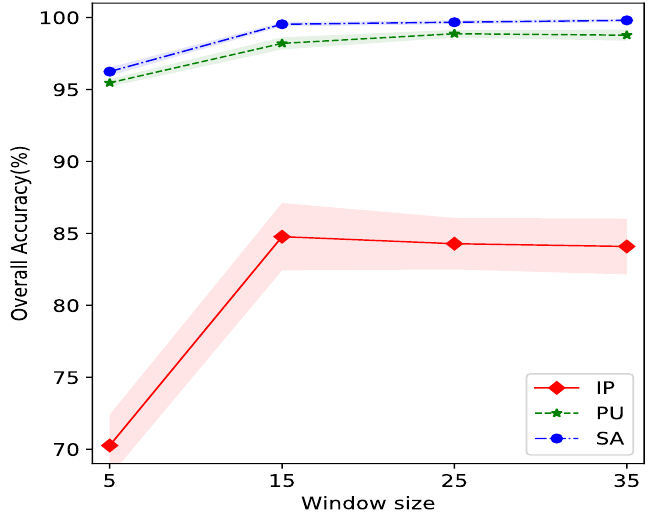
Figure 6. The effect of different window size on the overall accuracy of C-CNN-Aug.